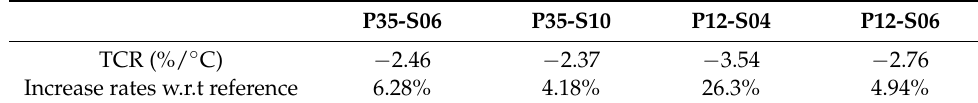
Figure 13. Comparison of low-frequency noise characteristics at 10 Hz of the a-Si microbolometers treated with the PMA process and the reference devices. Table 5. Low-frequency noise characteristics of the four types of a-Si microbolometers applied with the PMA process extracted at 10 Hz and the increase/decrease rate compared to the reference. P35-S06